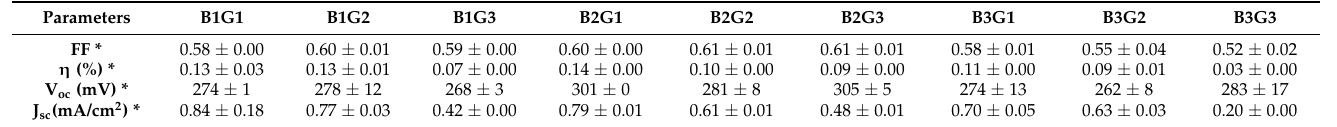
Table 5. Photovoltaic performance parameters of DSSCs based on the use of the COF RIO-60 as a dye replacement for the different batches under simulated AM 1.5 G illumination at 100 mW/cm 2 . ( The presented results correspond to the best performing cell ).